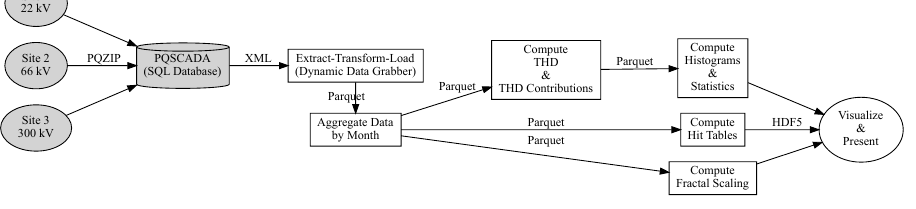
Figure 2. Dataflow (left to right) from source to analysis. Boxes indicate processing steps and text on arrows indicates the file format used. Grey shading indicates proprietary technology. Unshaded steps are our own scripts (based on the Python). The ETL (Extract-Transform-Load) steps interact with E LSPEC ’s proprietary PQSCADA system (using our own Dynamic Data Grabber package) to extract voltage and harmonics data as dataframes into Parquet files. Dataframes are aggregated by month and then consumed by various analysis scripts. These output data in HDF5 format for use by plotting